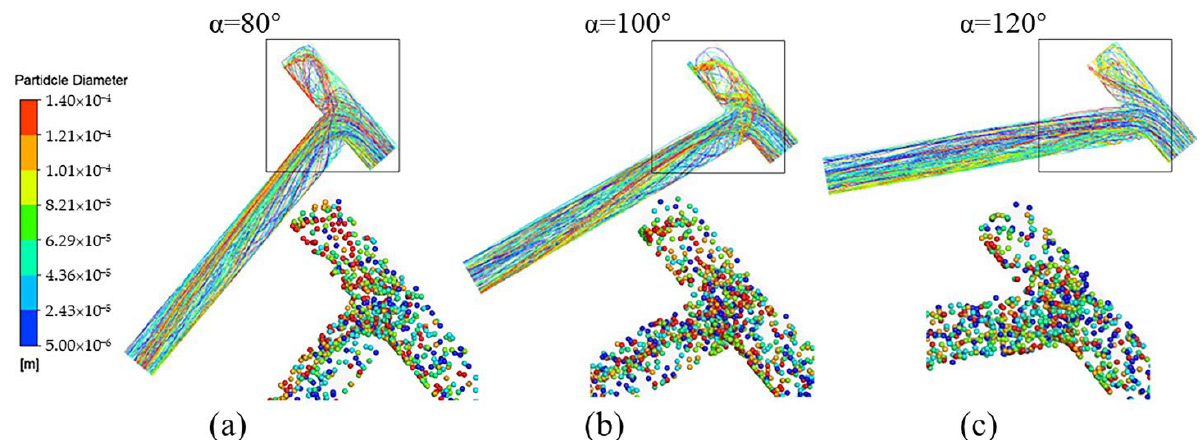
Figure 16. The local pressure distribution in the flue at the different angle α . ( a ) α = 80 ◦ ; ( b ) α = 100 ◦ ; ( c ) α = 120 ◦ .